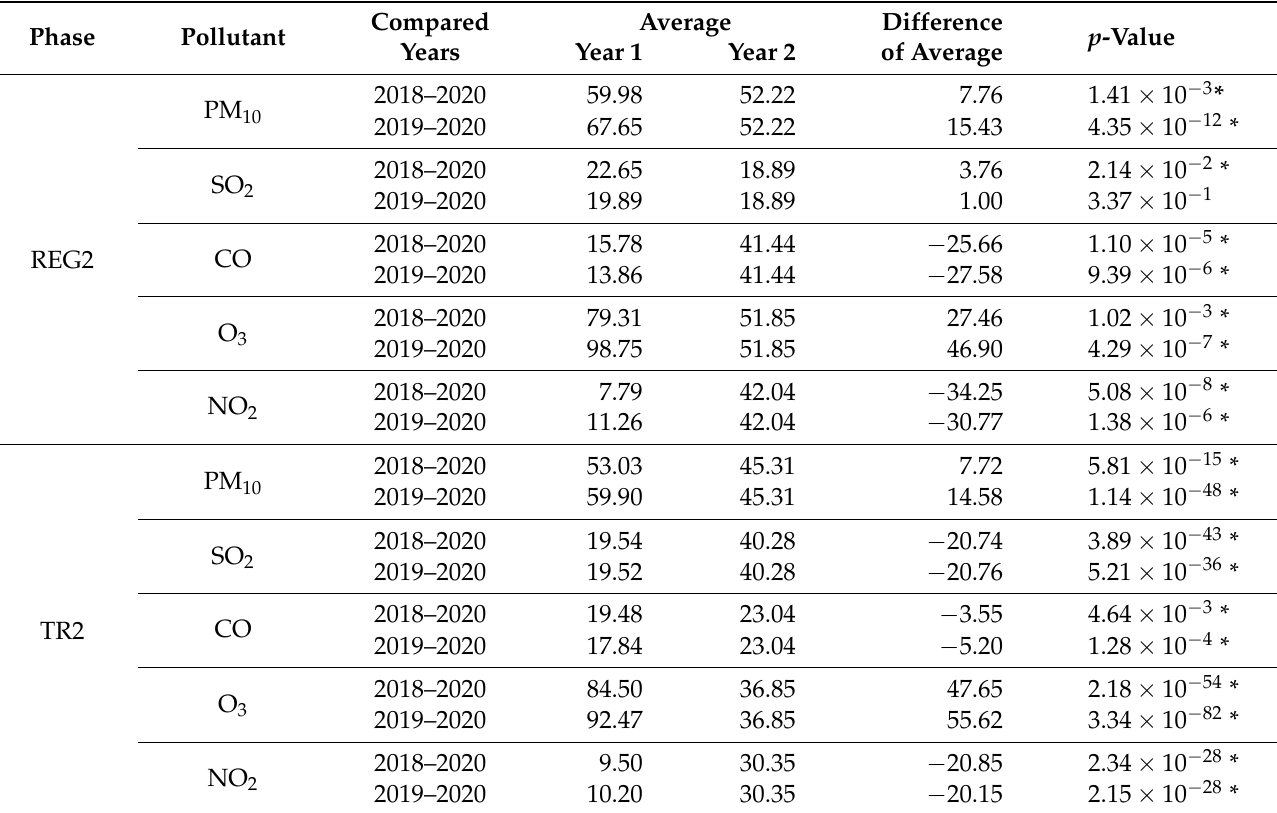
Table 7. The change of average AQI from 2018 and 2019 to 2020 of each pollutant within the REG2 and TR1 phase. Compared Phase Pollutant